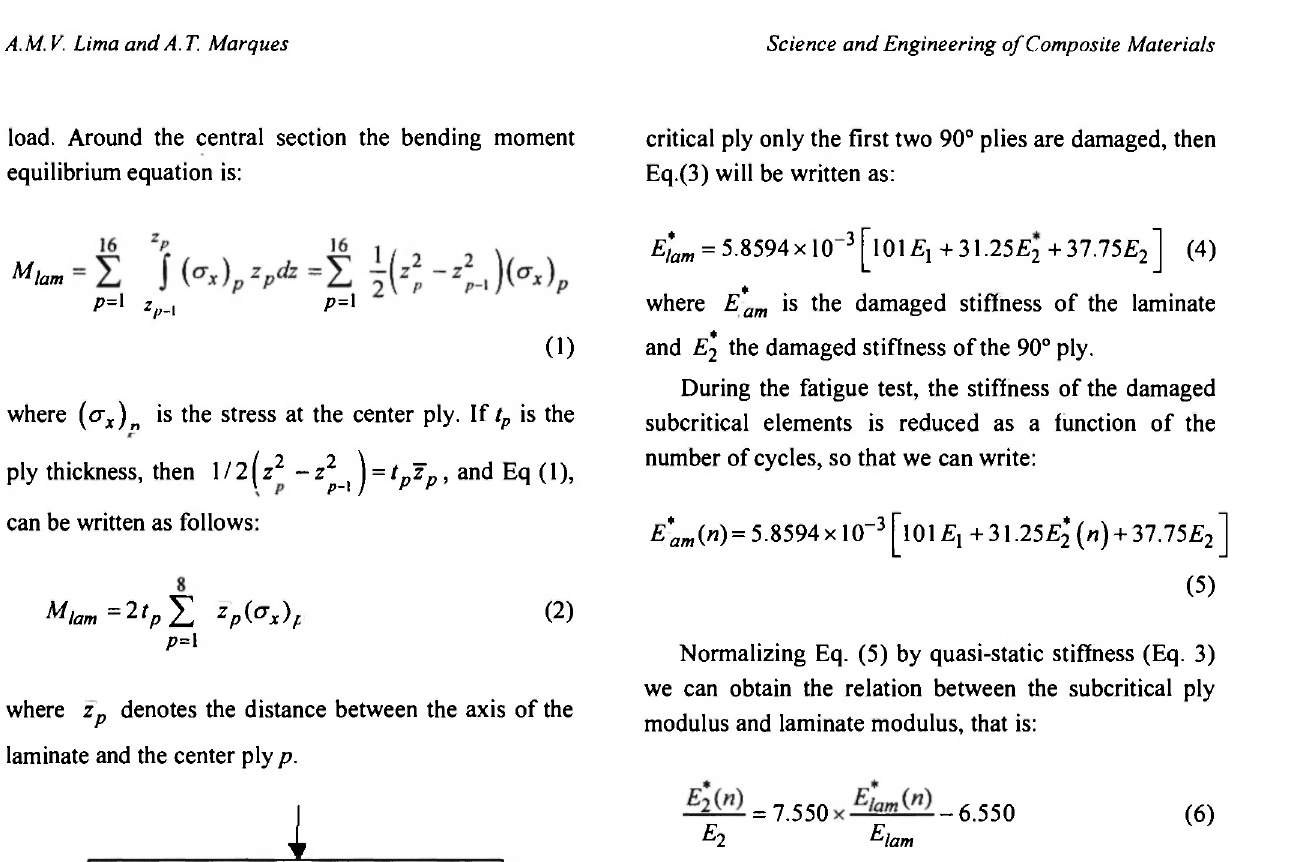
Fig. 1: Schematic of cross-ply laminate and definition